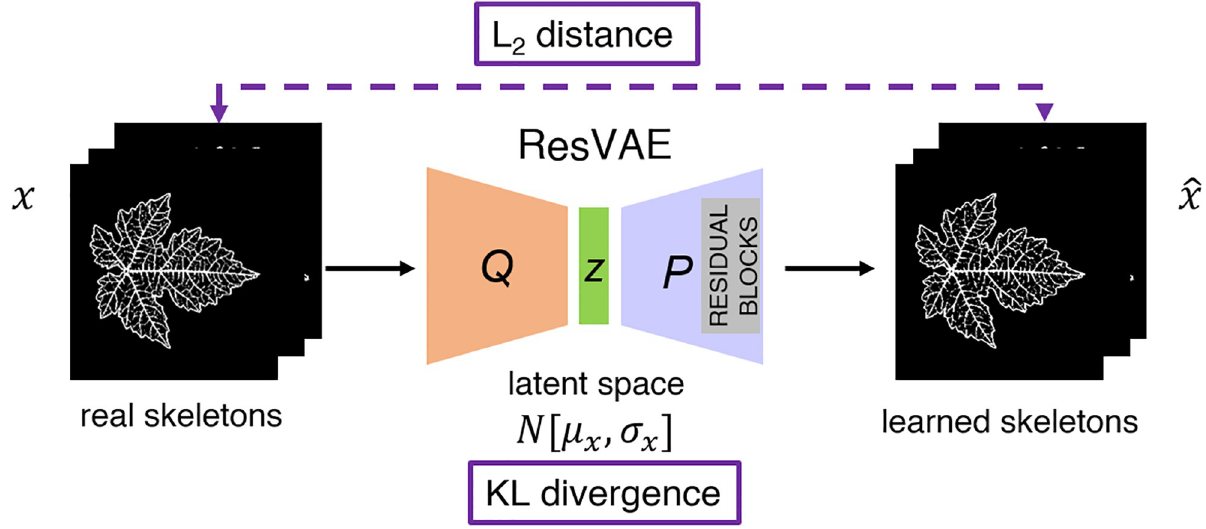
Fig 2. Illustration of the ResVAE architecture (training phase).